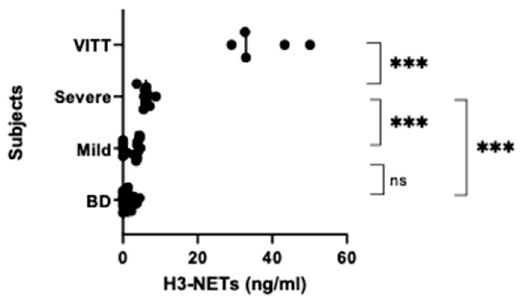
Figure 2. NETs levels. NETs levels were examined by a histone-3/ calprotectin ELISA in blood samples from ChAdOx1 nCov-19 vaccinated individuals that were divided into three groups (see Figure 1) according to severity of side effects. Group 1: VITT (n = 5), Group 2: Severe prolonged symptoms and signs (n = 10) who were assessed for but did not have VITT, Group 3: Mild brief symptoms (n = 15) with some headaches and general malaise who had visited emergency units but not needing further medical attention. Controls were samples from healthy (pre-COVID-19) blood donors (BD) (n = 20) donated before the pandemic. p < 0.0001 for one way ANOVA, for pairwise comparisons (two-tailed t -test): *** p < 0.0001, ns (not significant, here: p = 0.088).